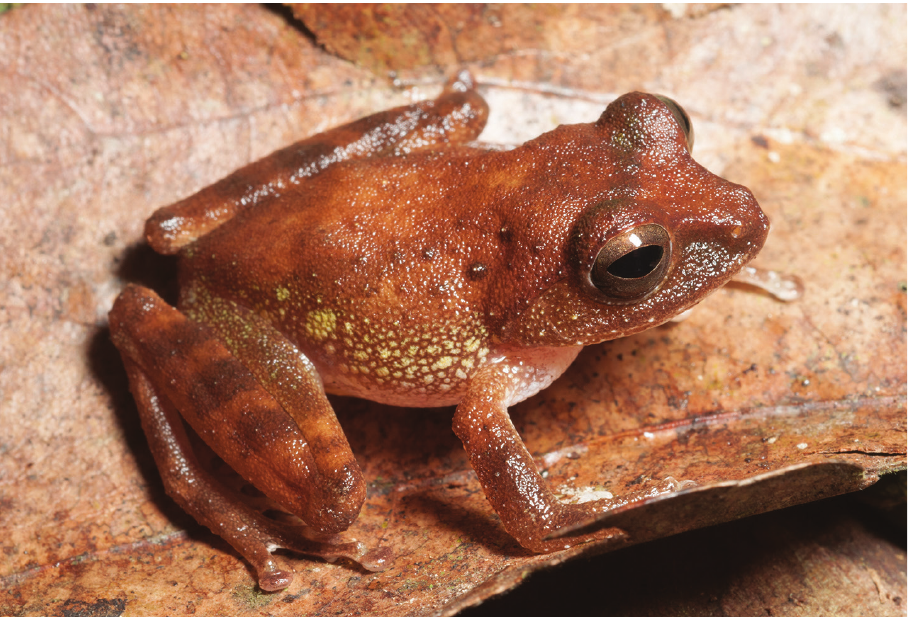
Figure 31. Philautus surrufus female from May-Impit, Mt. Hilong-hilong, Municipality of Remedios T. Romualdez, Agusan del Norte Province. Photo: